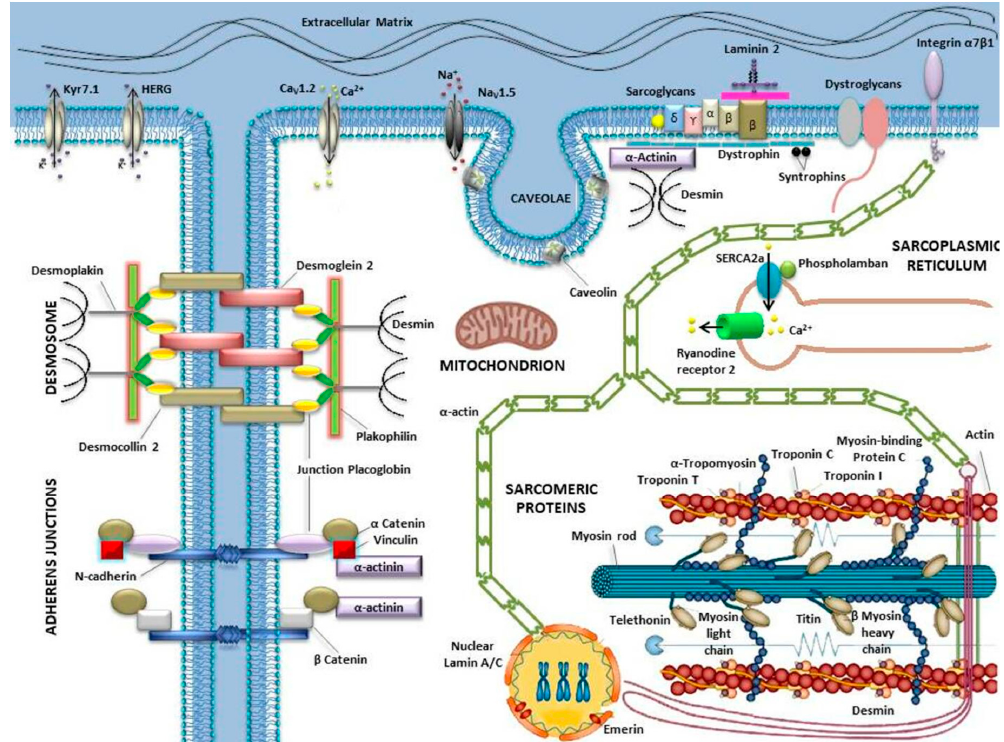
Figure 1. Cartoon of the cardiomyocyte components involved in the molecular mechanisms associated with sudden cardiac death (SCD). The figure illustrates the main ion channels (Kyr7.1, HERG, Cav1.2, Nav1.5, Ryr2) linked to channelopathies (long QT syndrome (LQTS), Brugada syndrome (BrS), catecholaminergic polymorphic ventricular tachycardia (CPVT)); sarcomere proteins associated to hypertrophic cardiomyopathy (HCM); proteins participating in the organization of desmosomes and adherents junctions, linked to arrhythmogenic cardiomyopathy (ACM); the cytoplasmic, mitochondrial, sarcoplasmic reticulum proteins and the proteins of the dystroglycan complex that are associated with the development of dilated cardiomyopathy (DCM).